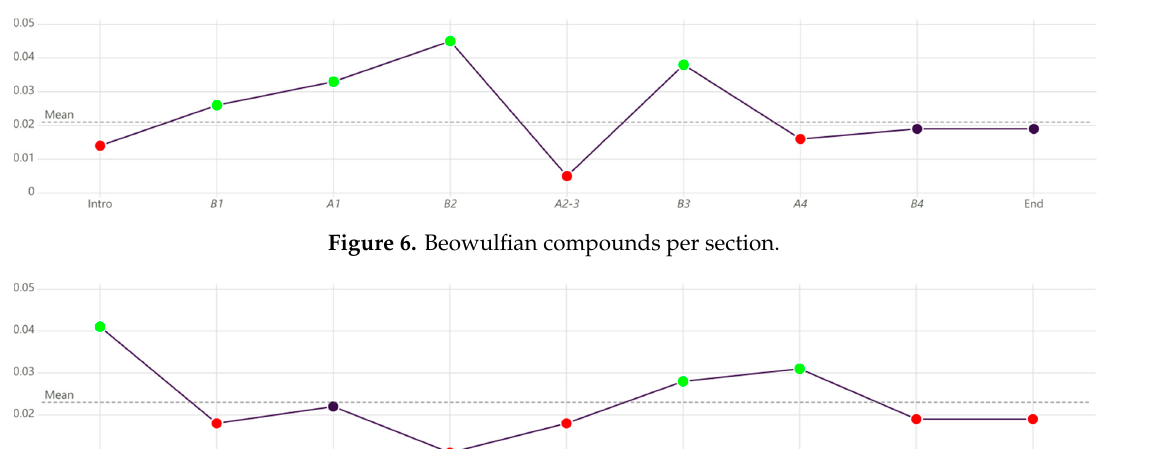
Figure 5. Beowulfian parallels per section.